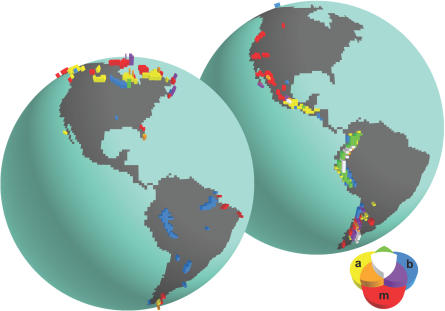
Geographic Distribution of Amphibian, Bird, and Mammal High and Low Beta-Diversity OverlapSpatial overlap in beta-diversity (βsim-d) for percentage sets of each taxon's lowest (left) and highest (right) 2.5% of βsim-d grid cells is shown. Primary colors indicate grid cells unique to one taxon (yellow, amphibians; blue, birds; red, mammals), secondary colors indicate overlap between two groups, and white indicates overlap of all three groups. The height of the grid cells reflects the number of overlapping groups. Note the greater degree of spatial coincidence in high βsim-d than in low βsim-d.